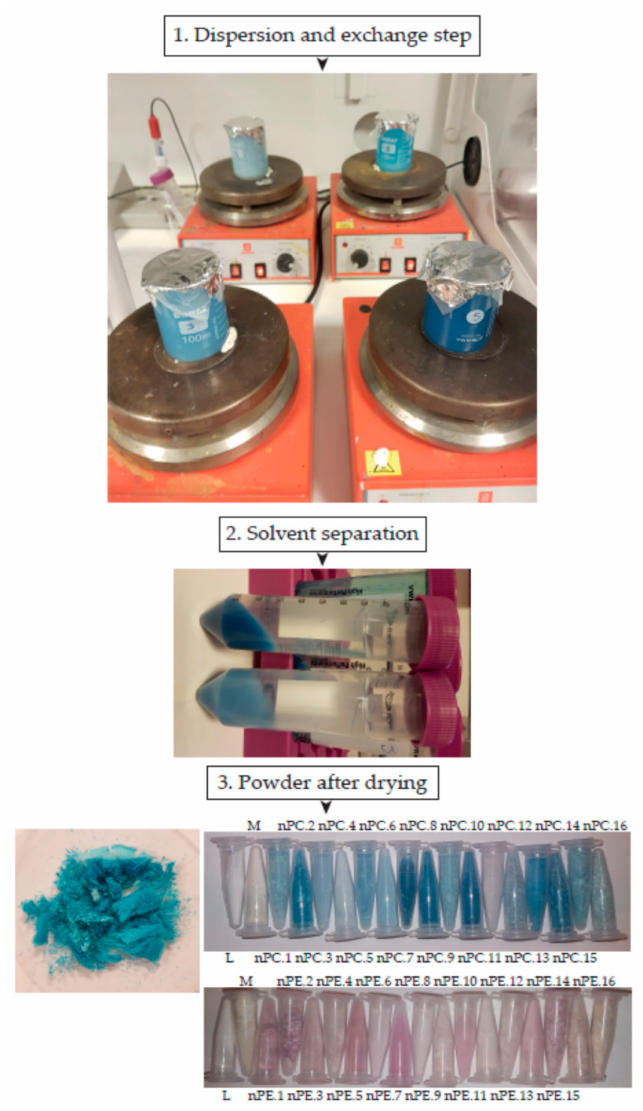
Figure 2. Pictures of the different synthesis steps and the results in the powder format for all the hybrid pigments with dyes PC and